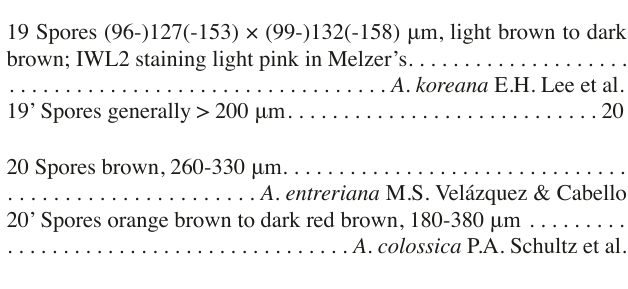
15 Spores always smooth on surface, light yellow to bright yellow to yellow brown, (95-)105-160 × (95-)100-150 μm . . . . . . . . . . . . . . . . . 15’ Spores with a smooth to roughened surface sometimes resembling a minute, pitted surface, (78-)106(-130) μm, deep yellow to brownish